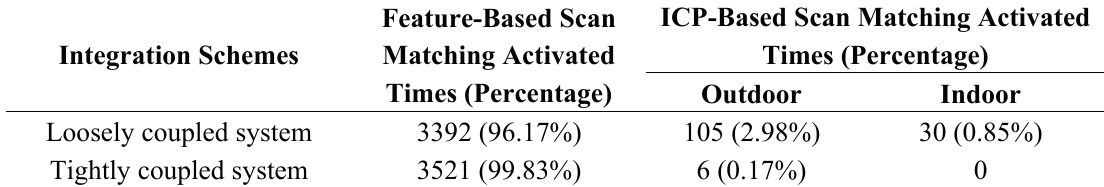
Table 2. Comparison of loosely coupled and tightly coupled INS/LiDAR systems.